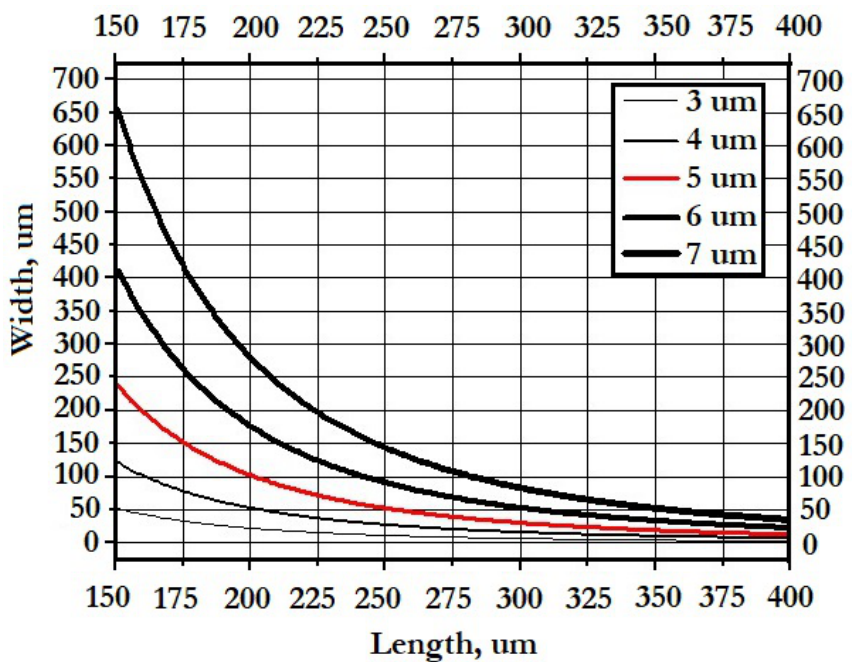
Figure 16. Dependence of the stiffness of the U-shaped elastic beam on the design